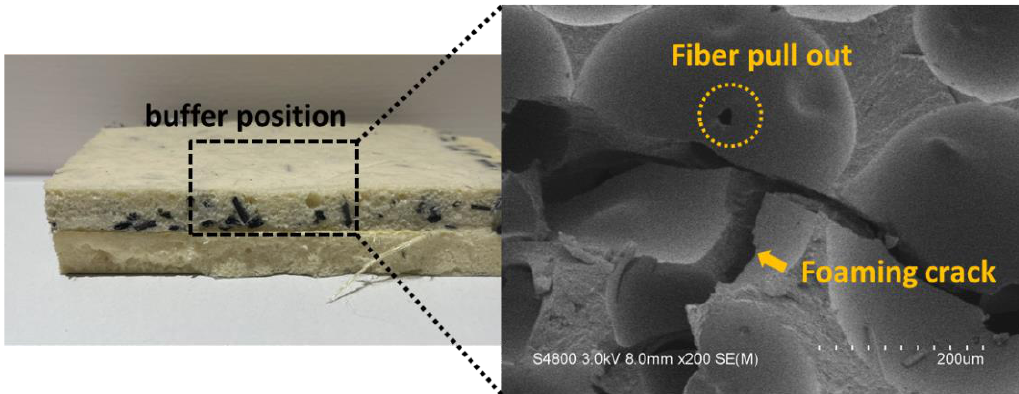
Figure 4. SEM images of PU foam composites after the buffer absorption test.